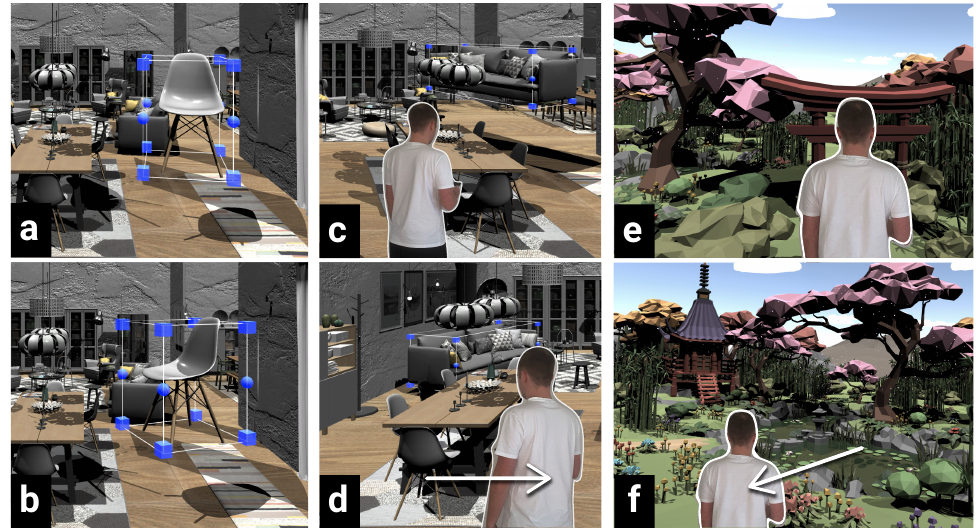
Figure 11. Applications to showcase the various utilities of TrackPhone. 3D Studio for testing interaction techniques by rearranging and manipulating furniture ( a , b ). Head-tracking used to create a parallax effect ( c , d ). Open game scene to use body and head motion for travel ( e , f